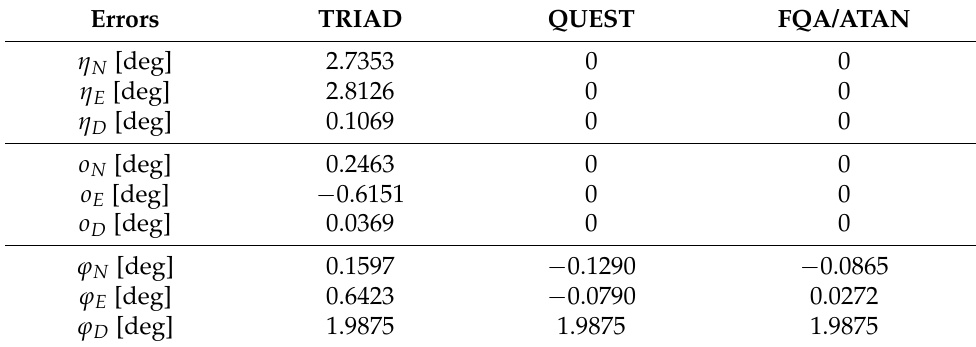
Table 5. Predicted DCM normality, orthogonality, and alignment errors in experimental test.